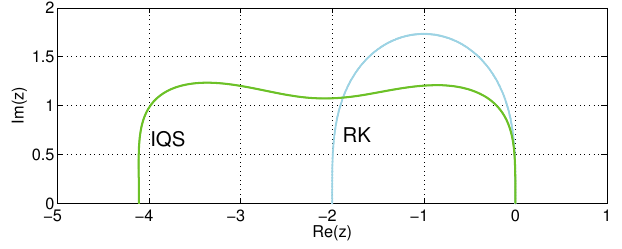
Figure 1. Stability regions of RK method of order p = 2 and GLMs with p = s = r = 2, q = 1 with